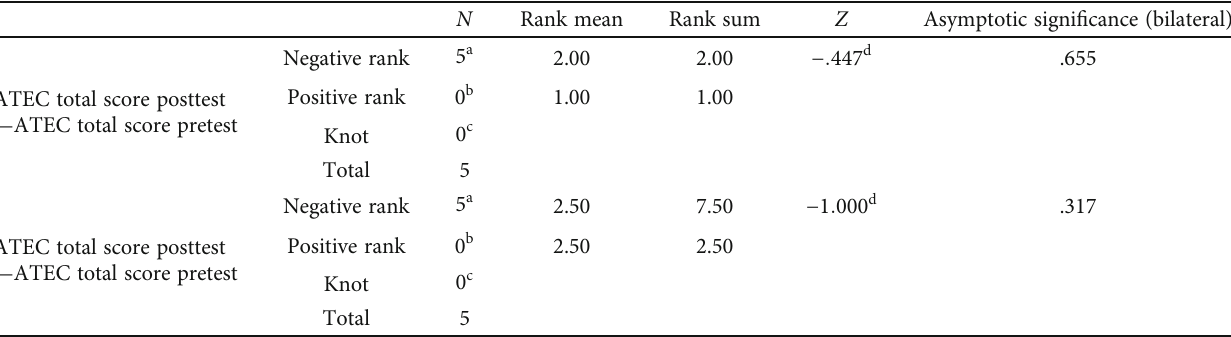
Table 4: Signed-rank sum test results of the scores of each subscale of ATEC in children in the control group. N Rank mean ATEC total score posttest — ATEC total score